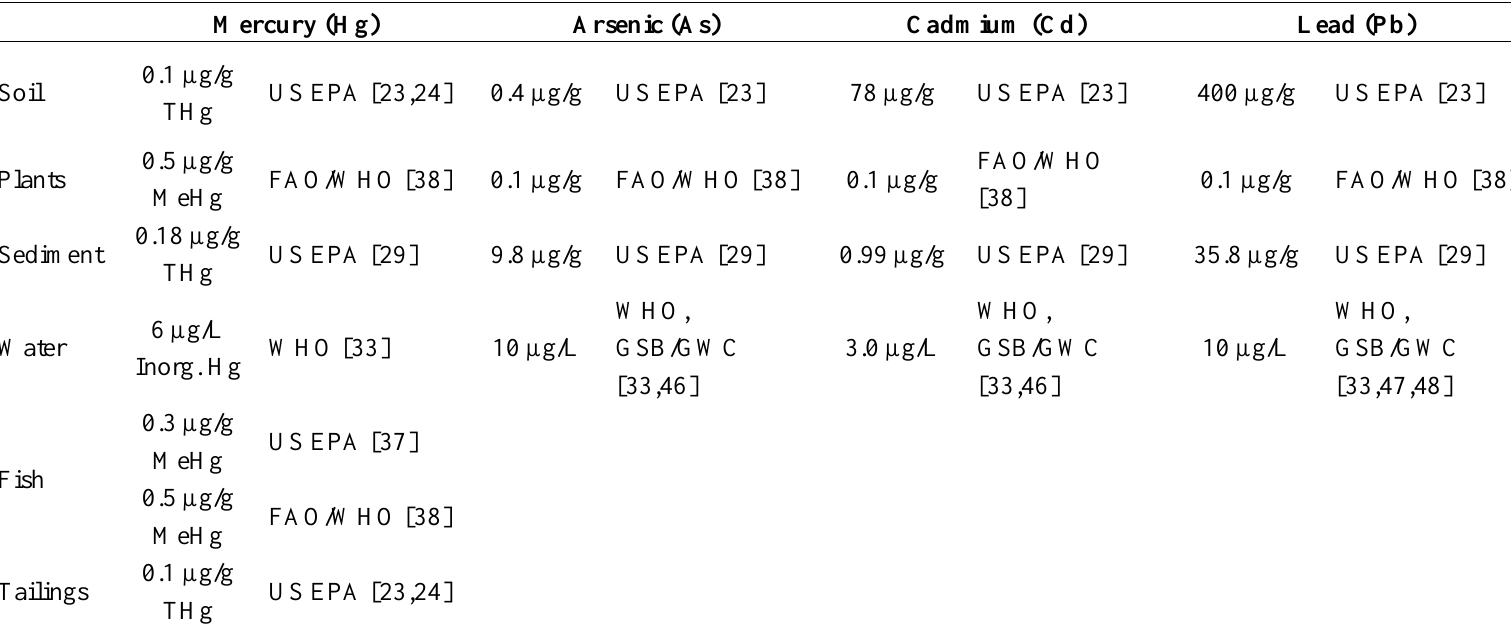
Table 1. Summary of guideline values for mercury (Hg), arsenic (As), cadmium (Cd), and lead (Pb) in soil, plants, sediment, water, fish, and